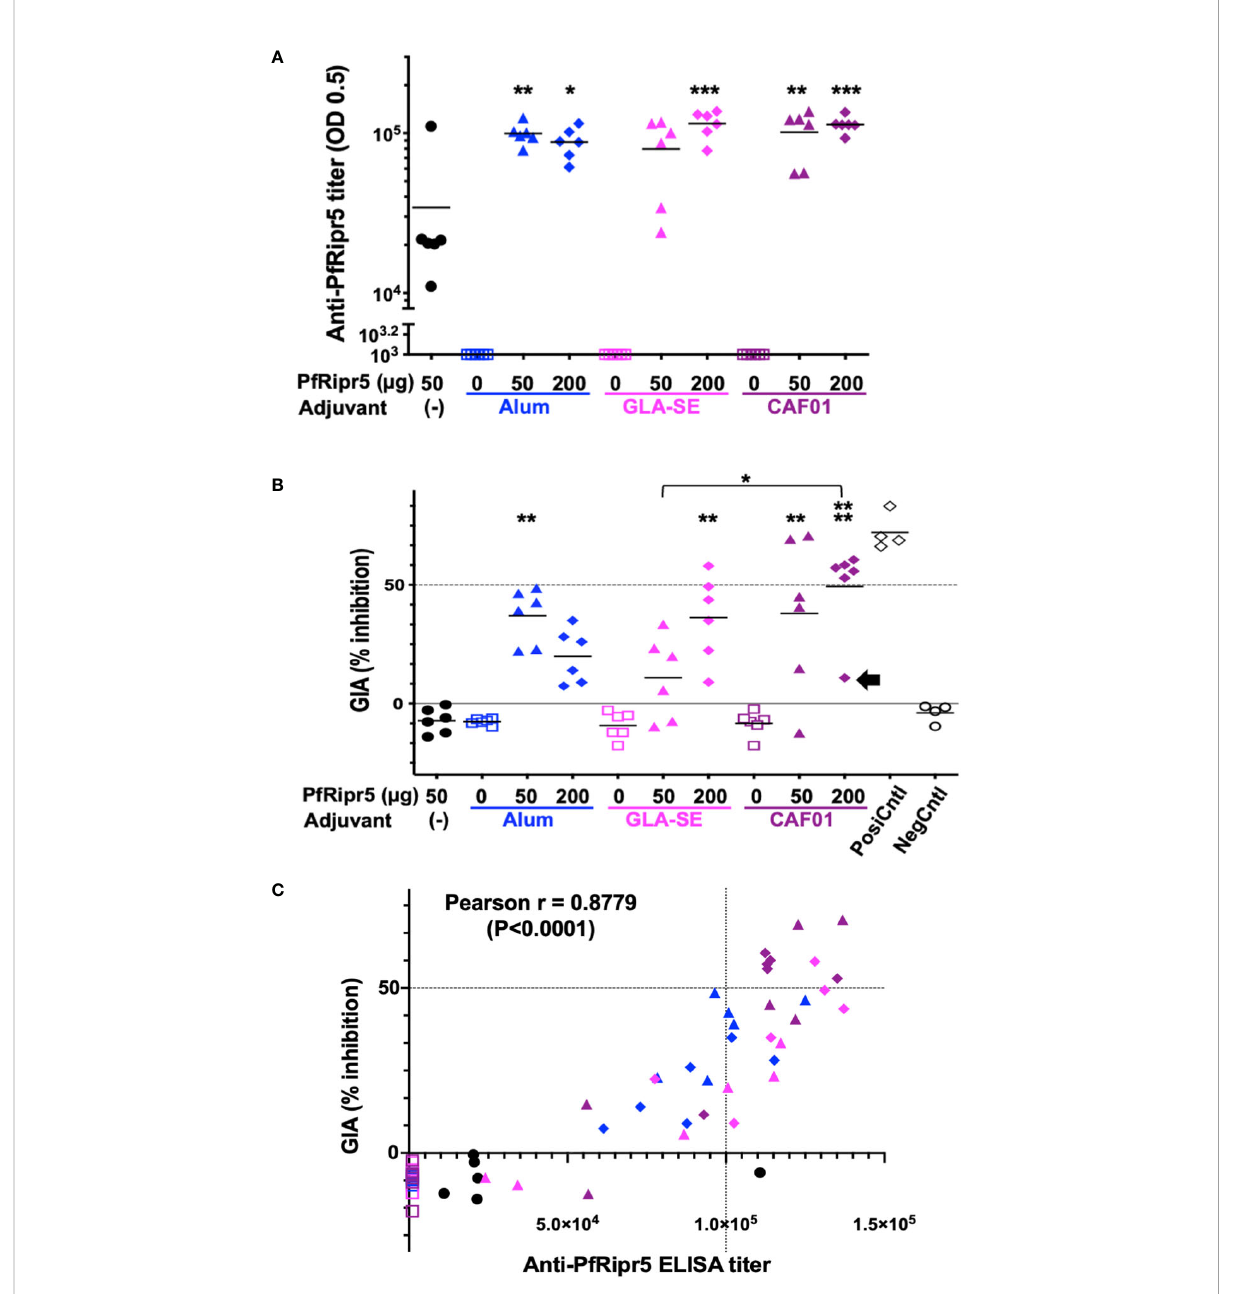
FIGURE 2 Immunogenicity of adjuvanted PfRipr5 and GIA activity of anti-PfRipr5 rabbit antibodies. PfRipr5 antigen only [(-); black fi lled circles], Adjuvant only (open squares), 50 µg dose of PfRipr5 ( fi lled triangles), 200 µg dose of PfRipr5 ( fi lled diamonds), formulation with Alhydrogel ® (Alum; blue), GLA-SE (GLA; magenta), and CAF ® 01 (CAF; purple). Difference of the mean antibody titers and GIA activities among groups was tested by one- way ANOVA with Tukey ’ s multiple comparisons test. P values less than 0.05 was considered as statistically signi fi cant difference and all the asterisks represent the signi fi cant difference against the PfRipr5 without adjuvant group unless otherwise indicated (*P<0.05; **P<0.01; ***P<0.001; ****: P<0.0001). (A) ELISA titer of anti-PfRipr5 antibodies. Reciprocal serum dilutions that gave a mean absorbance at 492 nm of 0.5 were determined as the endpoint titers. OD, optical density. (B) GIA activities of the total IgG puri fi ed from anti-PfRipr5 antibodies. For each GIA, four independent experiments were carried out in triplicate to con fi rm reproducibility and each data point represents average GIA of each rabbit IgG samples in four independent experiments. Rabbit IgGs immunized with Freund adjuvant formulated PfEBA175_region 3 to 5 (15) (PosiCntl; black open diamonds) and His-GST (NegCntl; black open circles) were used as a positive and negative controls, respectively. Black arrow indicates one outlier rabbit GIA data in the 200 µg PfRipr5/CAF ® 01 group. (C) Correlation between anti-PfRipr5 ELISA titers and GIA activities (n = 60). Pearson ’ s correlation coef fi cient was calculated as r = 0.8779